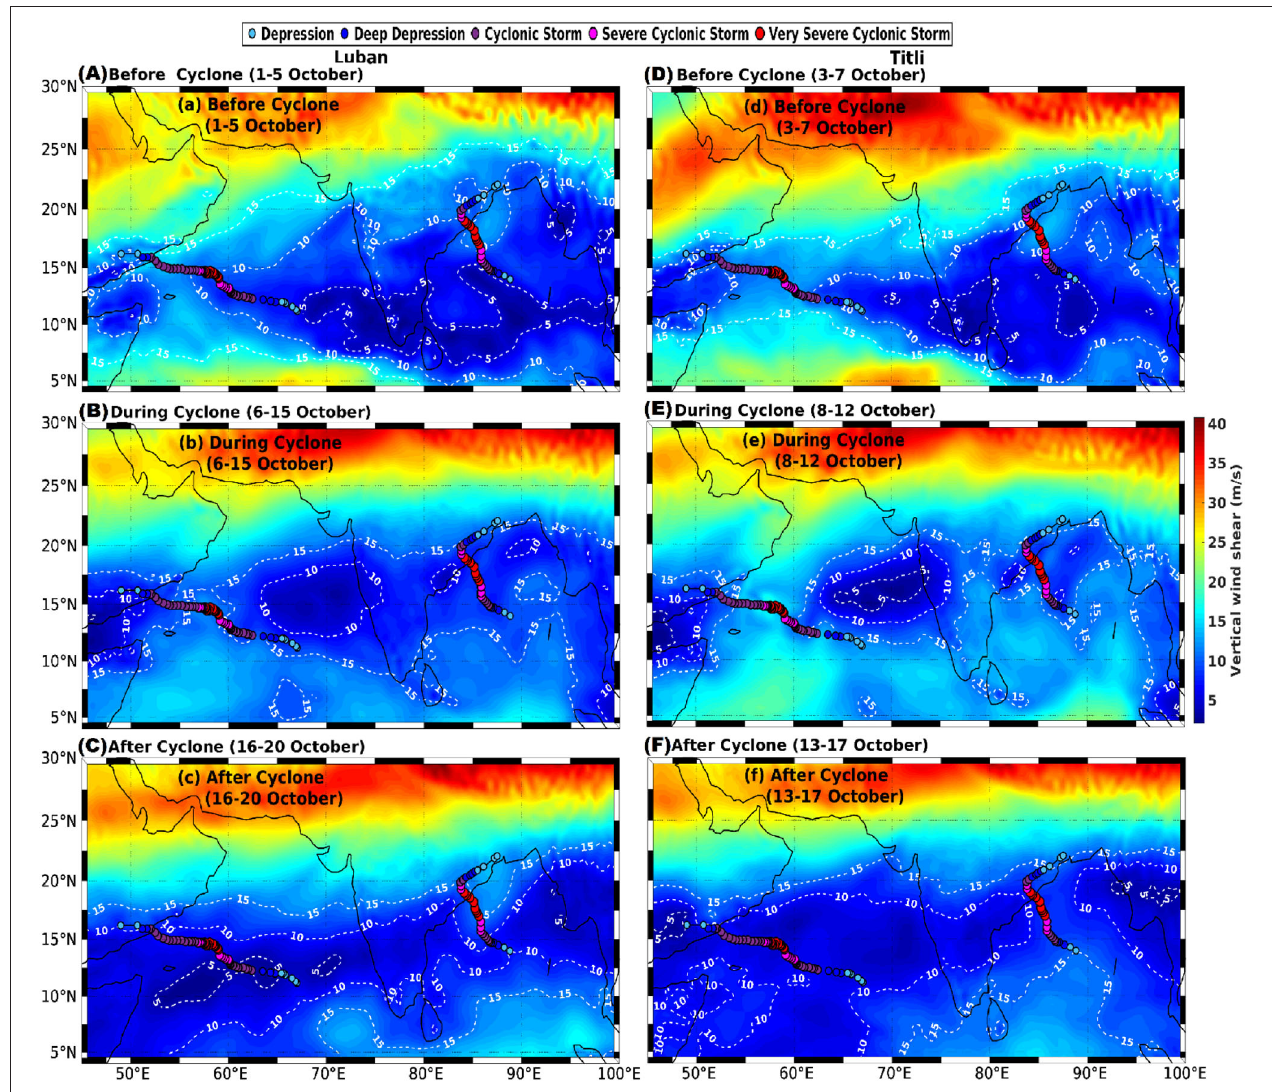
FIGURE 10 | A spatial map of vertical wind shear (difference between 200 and 850 hPa) (m/s) before (A,D) , during (B,E) , and after (C,F) cyclones Luban (A–C) and Titli (D–F) . The color-filled circles denote the track of the cyclone.